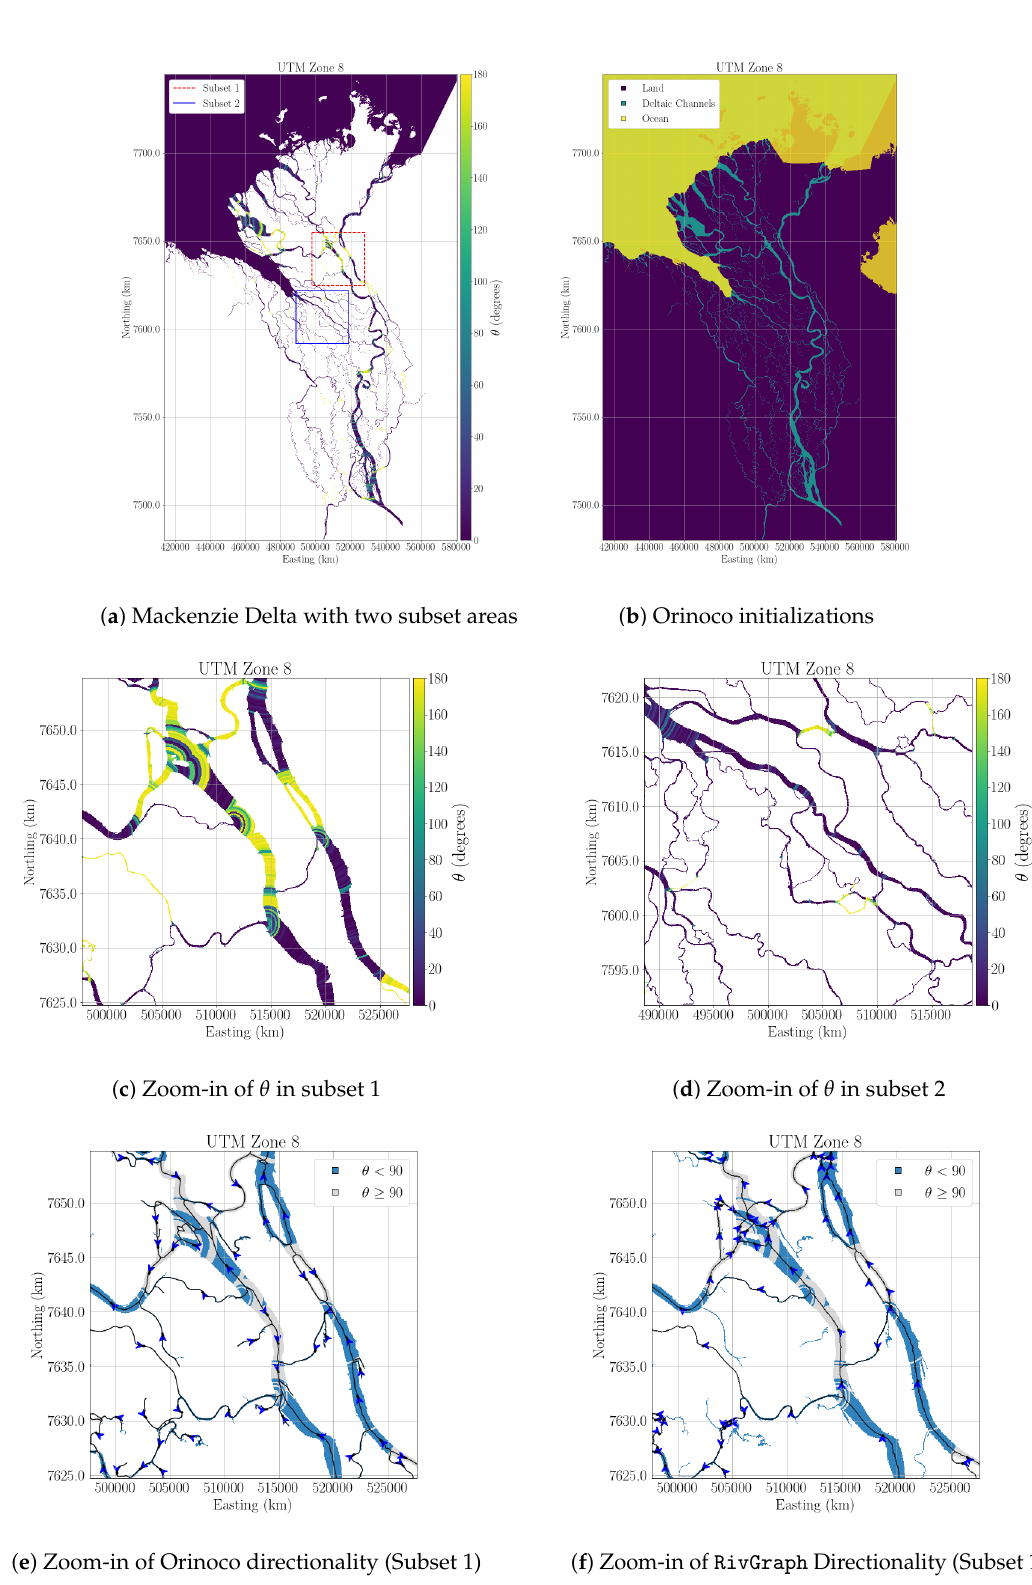
Figure 11. Estimated stream flow compared with RivGraph over the Mackenzie